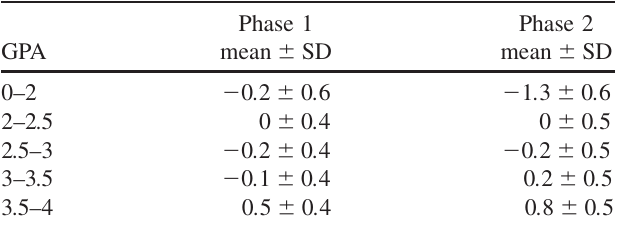
TABLE IV. Effects of GPA on N3L score.